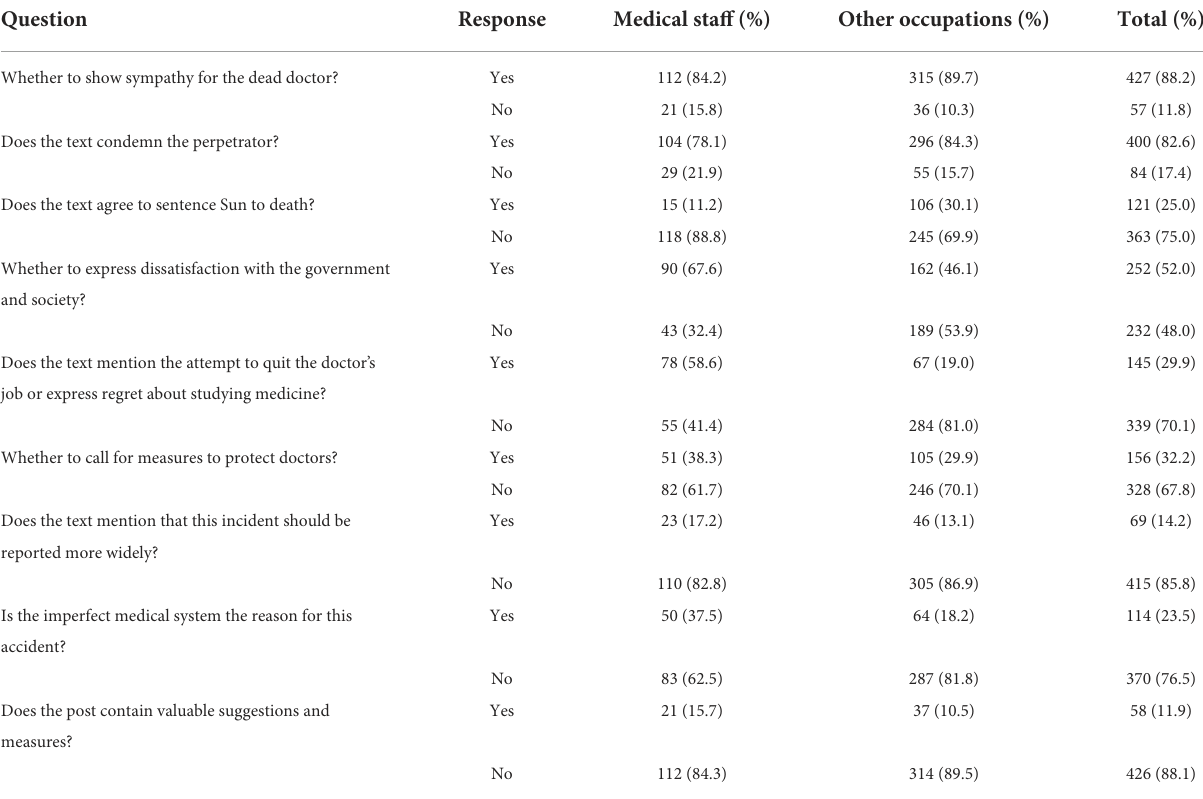
TABLE 2 Views of medical staff Weibo users and other profession Weibo users #